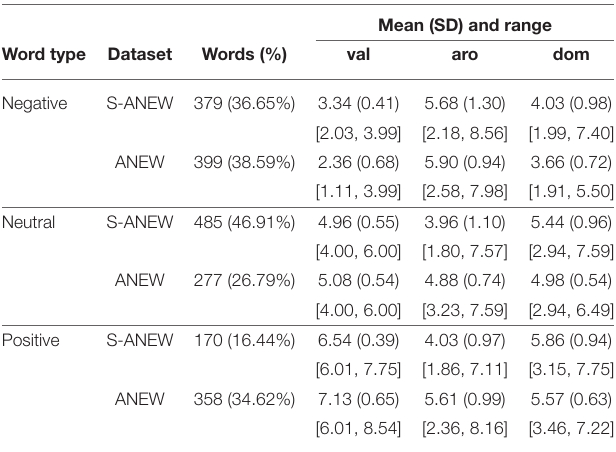
TABLE 2 | Words classified as negative, neutral, and positive by ranges of valence, both in Spanish S-ANEW and Redondo et al. (2007) ANEW. Mean (SD) and